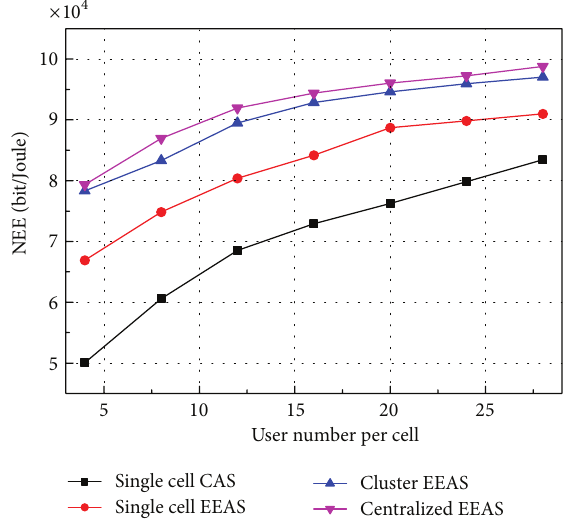
Figure 1: NEE versus User number per cell with 𝑁 max = 4, 𝑃 = 20 W, and cell radius of 1Km.